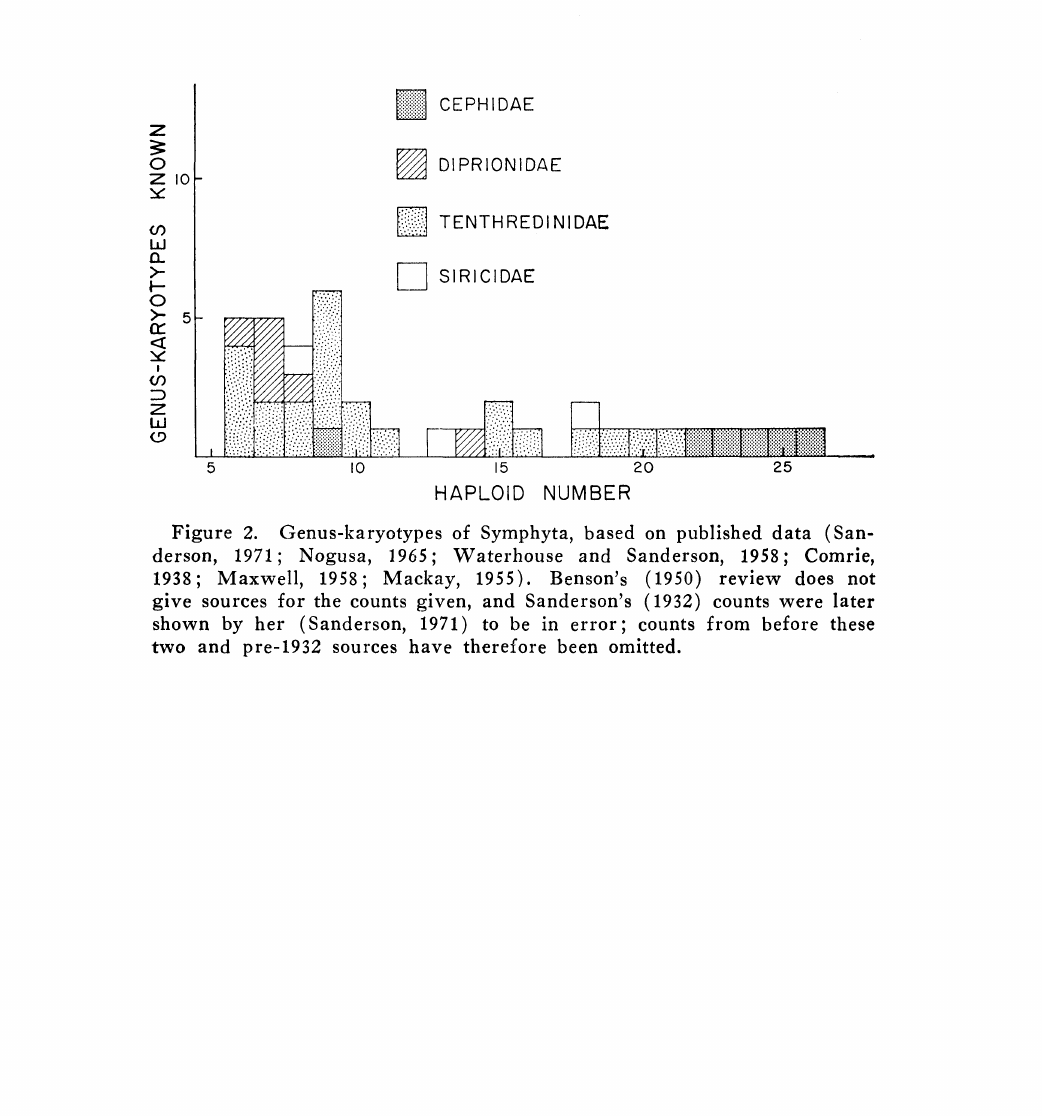
Figure 1. Karyotypes of 22, 24 ar.d 26 chromosomes of Janus integer.